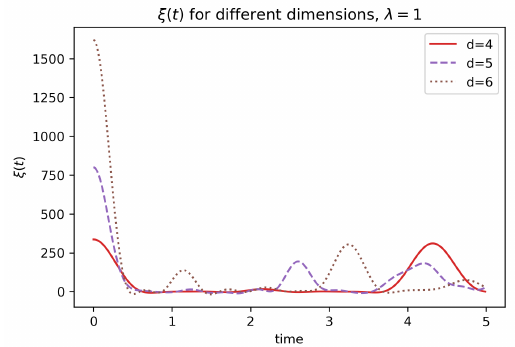
Figure 3: The function ξ ( t ) , defined in (19), for the spectrum of a Hamiltonian drawn from the d = 4,5,6 GUE, respec-